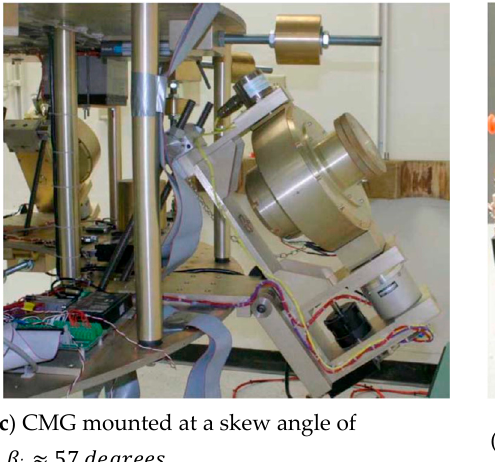
Figure 1. Control moment gyroscopes ( a ) placed onto a spacecraft mounted at a skew angle, with 𝛽 depicted here ( b ) in the former research benchmark with minimally redundant (four) gyros arranged in the shape of a pyramid skewed at the symmetric angle, 𝛽 . Notice the reduced vertical space occupied by the gyros in ( d ) compared to the vertical space occupied by the gyro in ( c ). This vertical space reduction is one reason why engineers might need to understand configurations with one or more gyro mounted at disparate skew angles resulting in an asymmetric configuration.